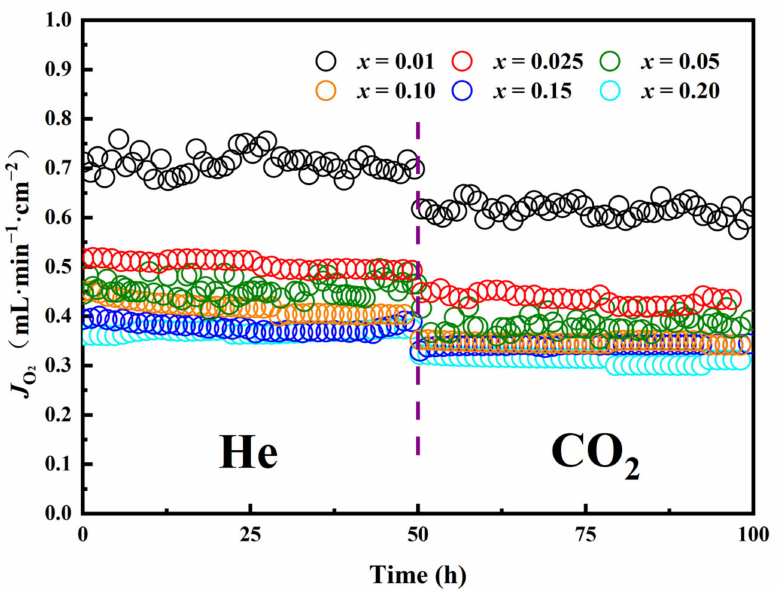
Figure 9. Stability test of 60CPO-40PSF 1 − x B x O OTMs at 1000 ◦ C for 50 h: oxygen permeation fluxes ( J O2 ) as a function of time under He or CO 2